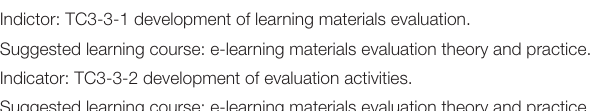
TABLE 6 | Teaching team aspect – course design and application. Level: TC1 analysis Level: TC3 development Sub-level: TC3-3 evaluation